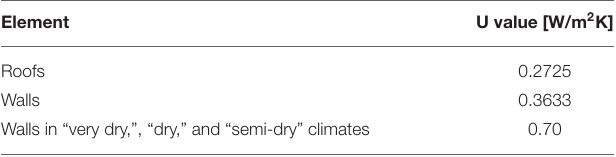
TABLE 4 | Thermal transmittance of diverse materials in Mexican